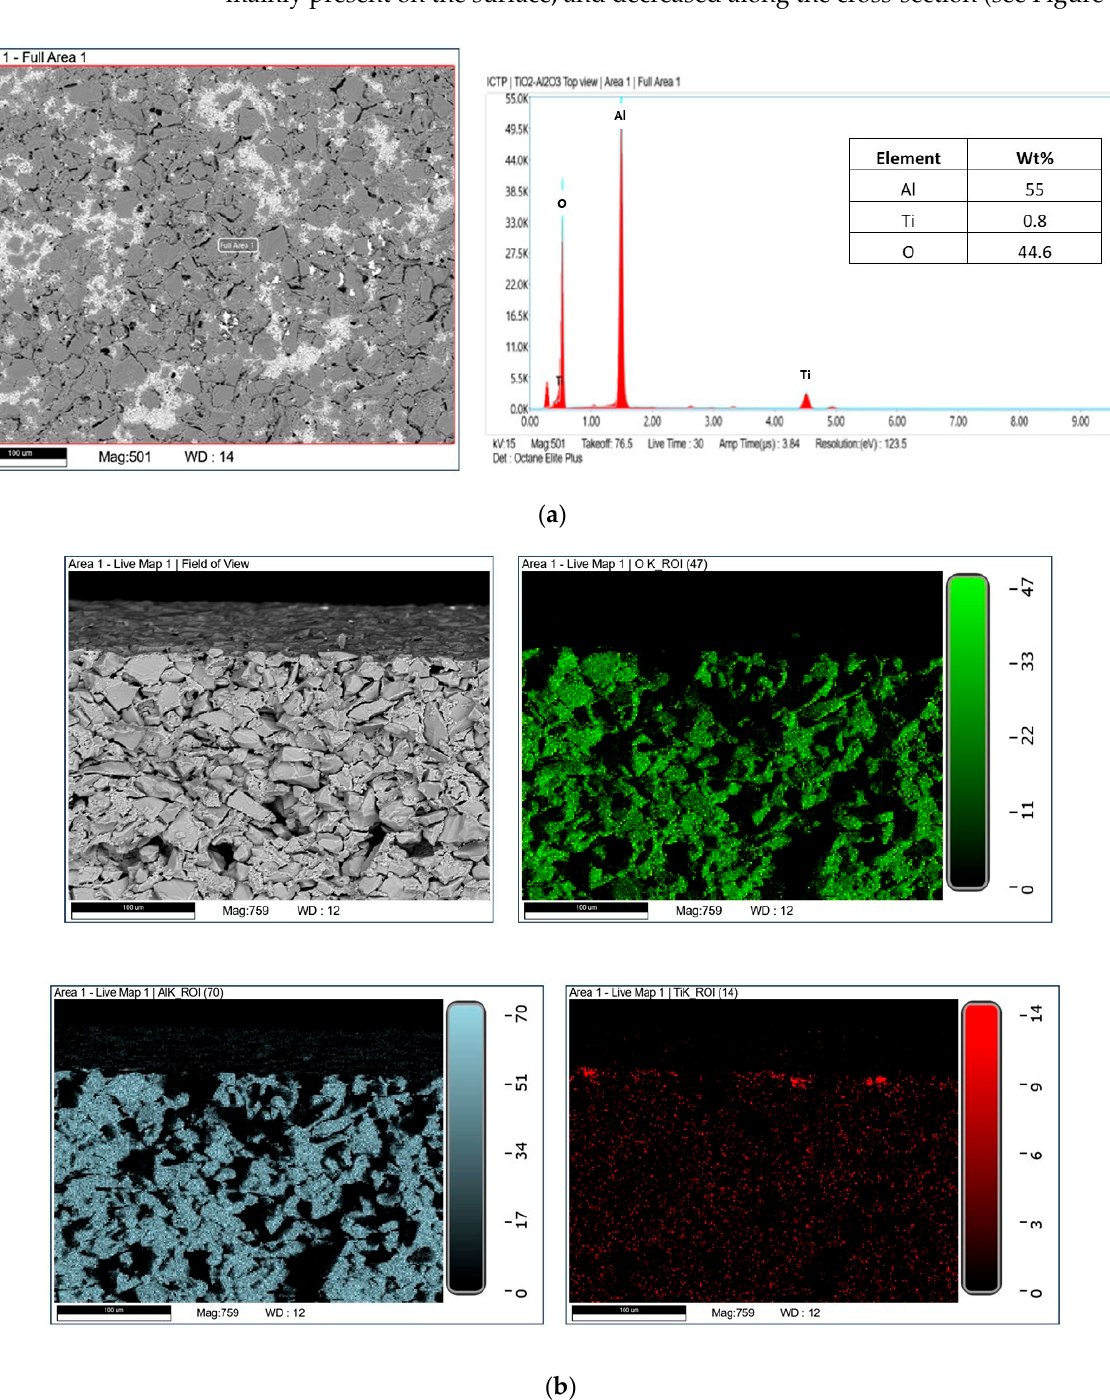
Figure 6. EDX analysis of the photocatalytic membrane; ( a ) top-view and ( b ) cross-section. The hydraulic permeance of pristine membranes is about 1500 Lm − 2 h − 1 bar − 1,